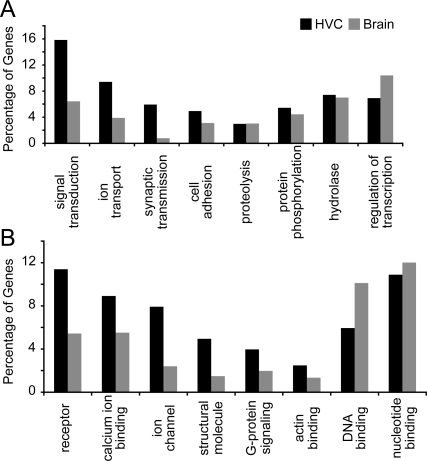
AgBase (http://www.agbase.msstate.edu/) was used to assign GO terms (www.geneontology.org) to as many genes as possible from the FDR <0.05 marker list, and to a set of a randomly sampled 1415 ESTIMA Unigenes expressed in zebra finch brain (see text for details).(A and B) Bar graphs show the percentages of genes that were categorized as involved in a specific biological process (A) or activity (B) that minimally describes 3% of the genes in ESTIMA (Grey columns) or in the FDR<0.05 marker lists (Black columns). For each category, black columns with higher or lower percentages than the corresponding grey column are considered over- and under-represented in HVC, respectively. Because some genes are represented by more than one category, percentages in both graphs sum to more than 100%.